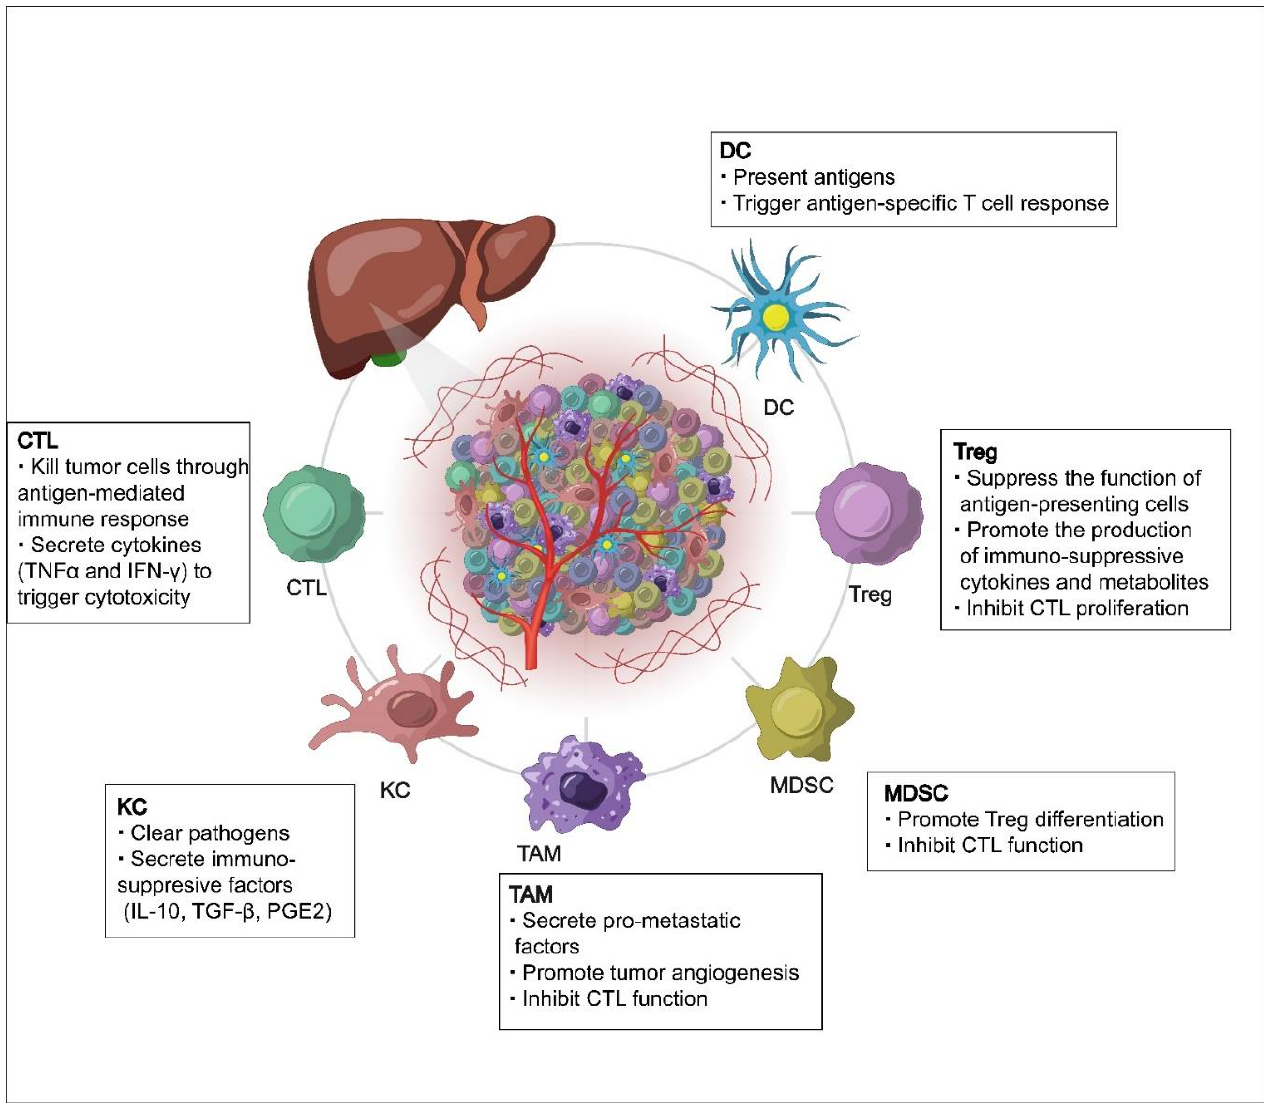
Figure 1. A schematic overview of the tumor immune microenvironment of hepatocellular carcinoma (HCC). Liver cancer cells and immune cells interact dynamically through cell – cell contact and the secretion and recognition of soluble factors, such as cytokines. Among various immune cells in the tumor microenvironment of HCC, regulatory T cells (Tregs), myeloid-derived suppressor cells (MDSCs), M2-type tumor-associated macrophages (TAMs), and Kupffer cells (KCs) suppress anti-tumor immunity, whereas cytotoxic T lymphocytes (CTLs) and dendritic cells (DCs) promote immune tumor rejection.